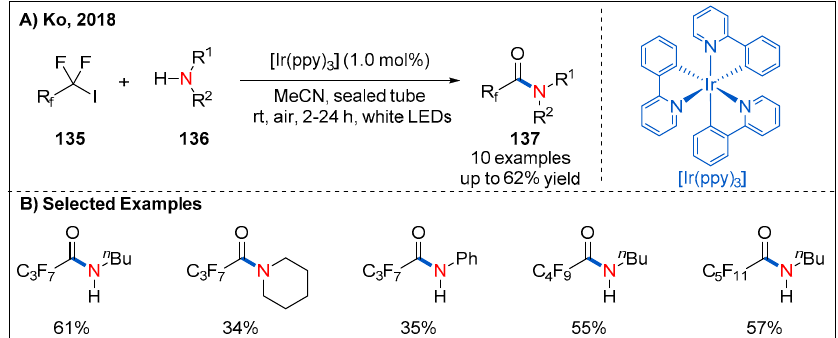
Figure 40. Photoredox-catalyzed synthesis of fluorinated alkyl amides from perfluorinated alkyl iodides and amines.